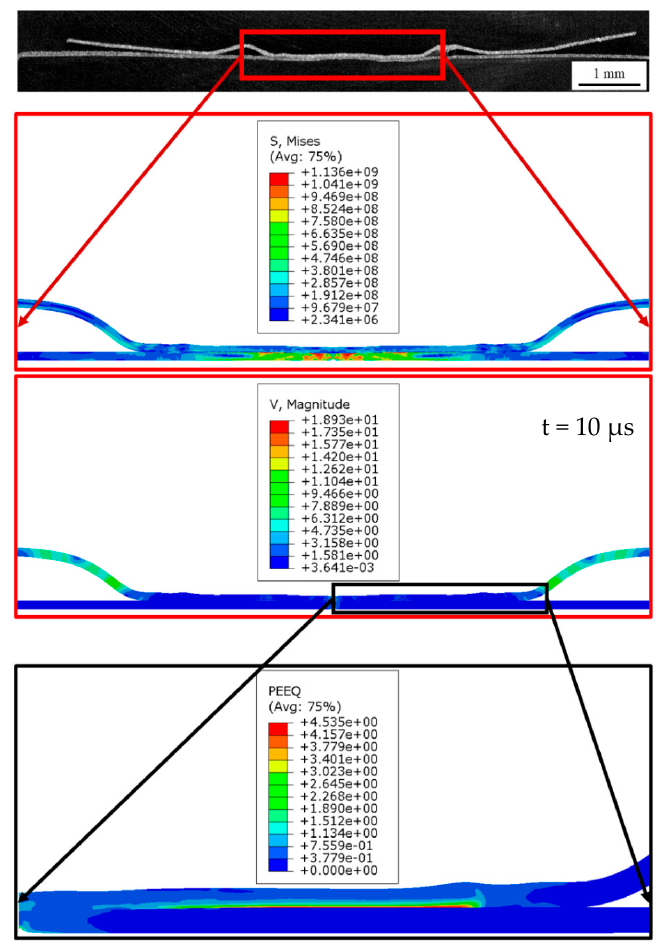
Figure 13. Axisymmetric simulation results: deformed shapes and comparison to experimental results; Contour plots include S: von Mises stress (Pa), V: velocity (m/s), and PEEQ: equivalent plastic strain.